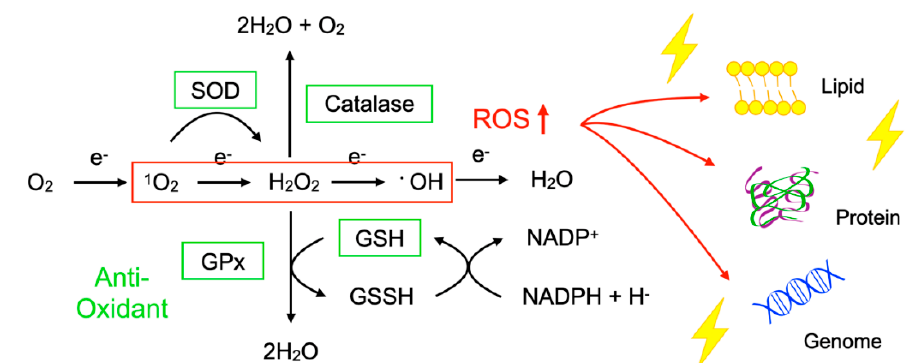
Figure 1. Imbalance between reactive oxygen species (ROS) and anti-oxidants impairs the function of macromolecules. ROS including superoxide ( 1 O 2 ), hydrogen peroxide (H 2 O 2 ), and hydroxyl radicals